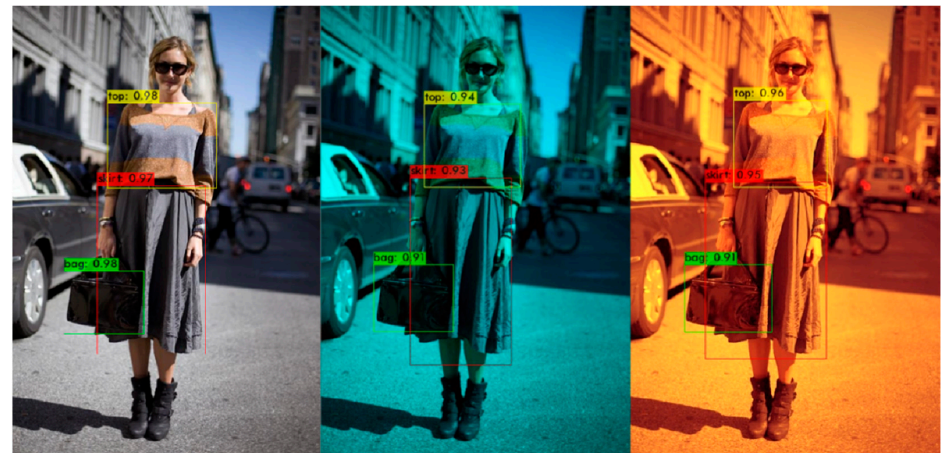
Figure 7. The detection results in different